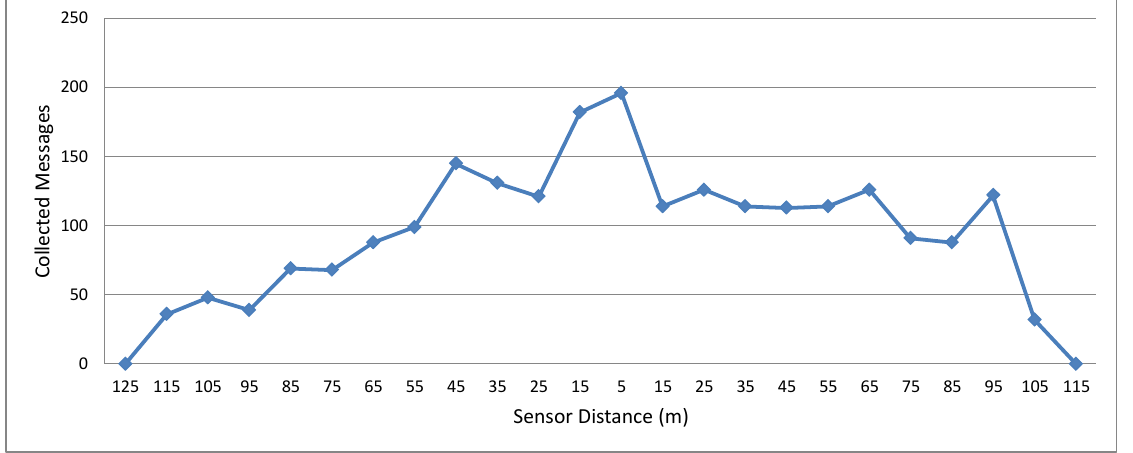
Figure 6. Histogram of messages collected by the